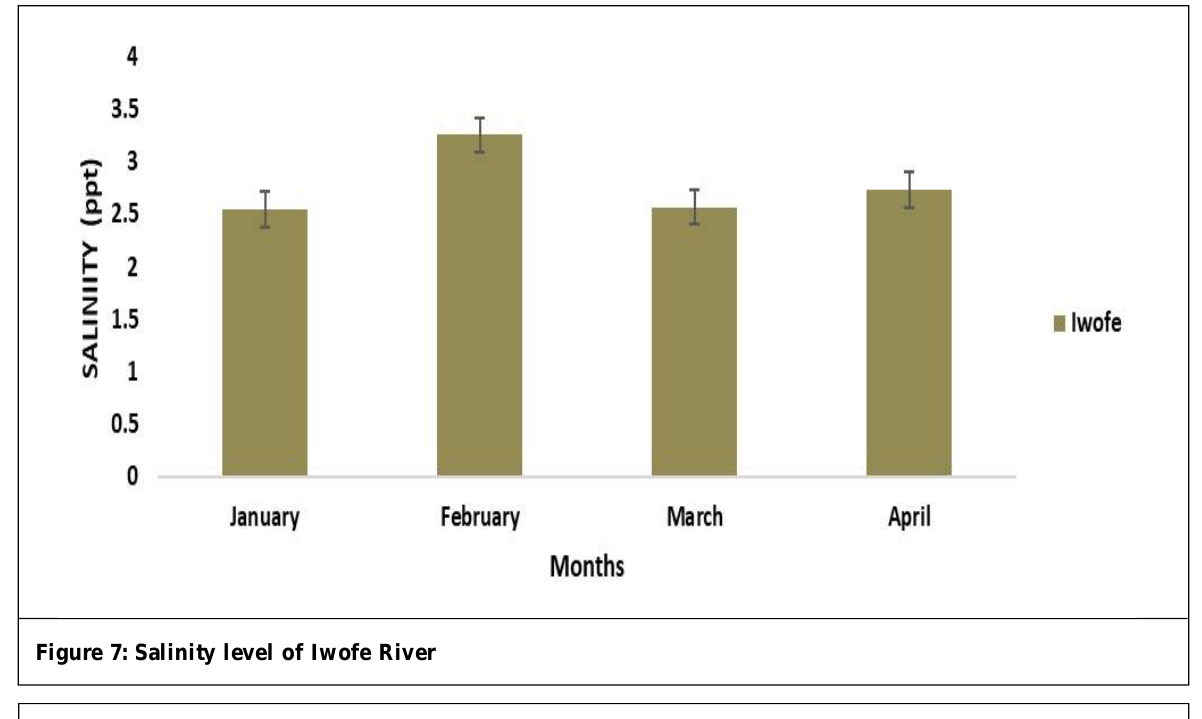
Table 2: Isopod parasite of fish in Iwofe Parasite